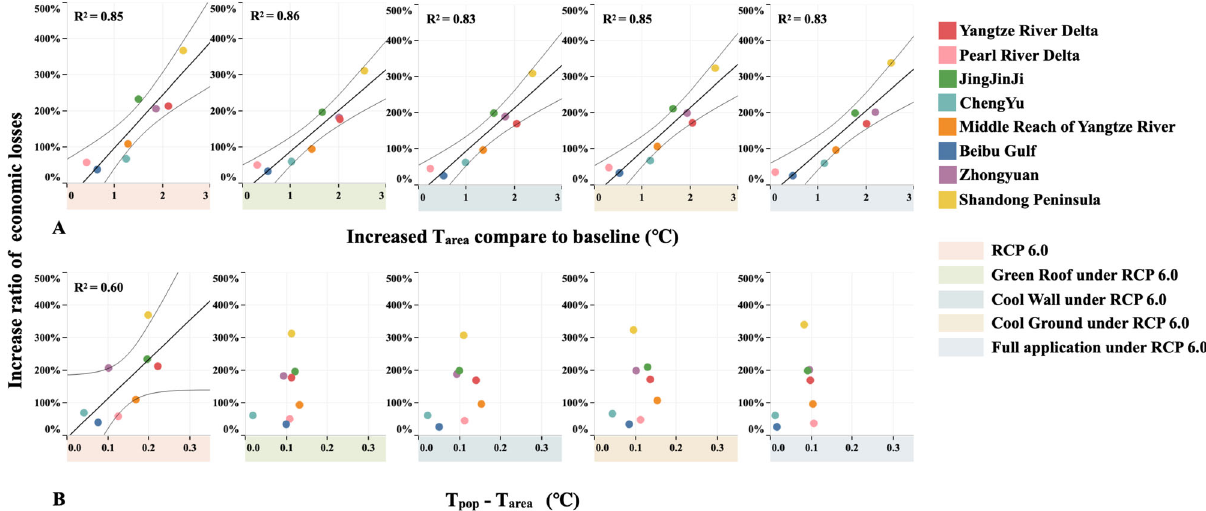
Fig. 5 Relationships among the increase in the ratio of economic losses, T area increase, and heat exposure increase induced by the resident distribution (T pop – T area ). A Relationships between the increase in the ratio of economic losses and T area increase under the different scenarios in individual urban agglomerations. B Relationships between the increase in the ratio of economic losses and resident distribution-induced increase in heat exposure. Linear regression is performed with a one standard deviation con fi dence interval. The bold lines indicate that the linear relationship is statistically signi fi cant at the 0.05